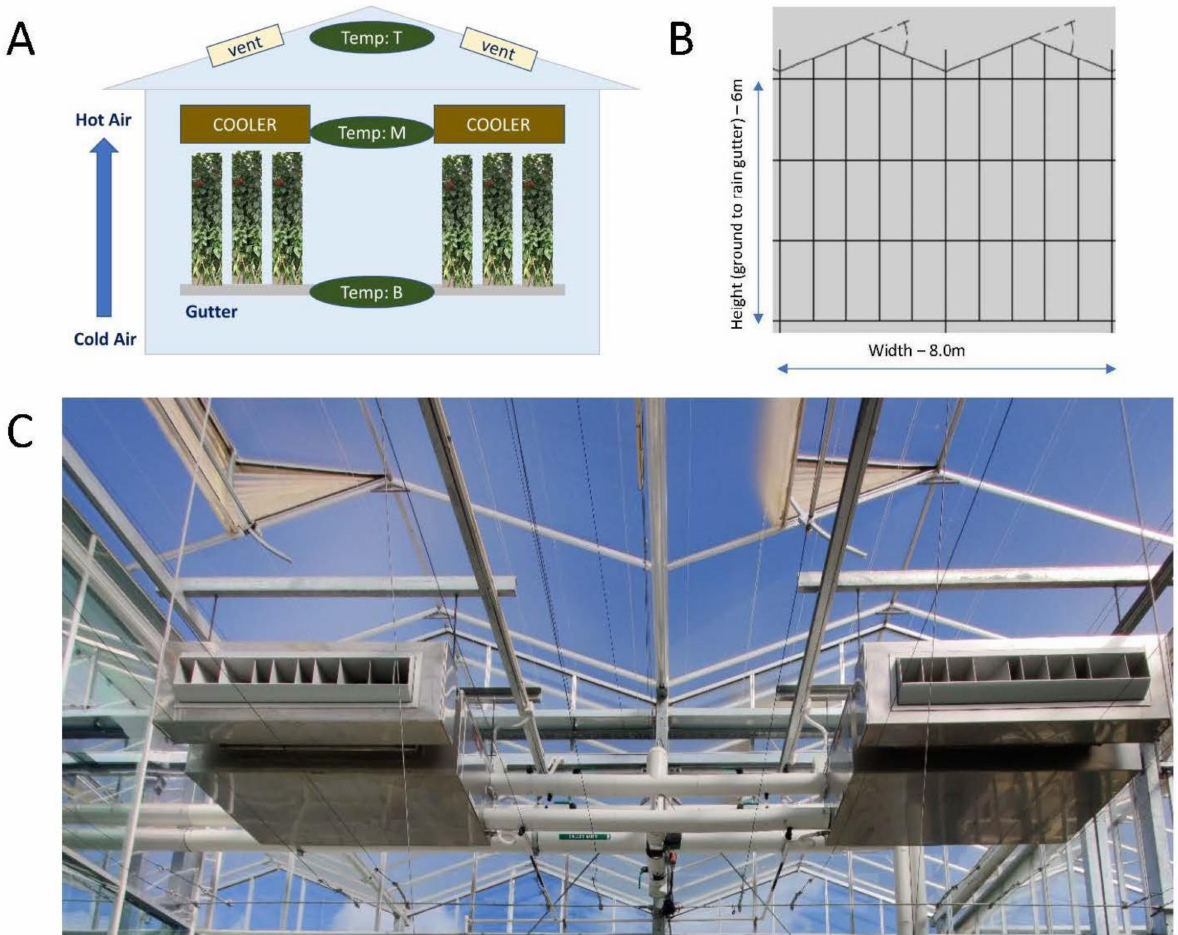
Figure 1. Research design and experimental configuration. ( A ) Schematic diagram of positions of the temperature sensors inside one of the experimental compartments. ( B ) The northwestern side of the greenhouse (13.6 m L × 8.0 m W × 6 m H (ground to rain gutter), depicting that both roof vents open toward the southwest. ( C ) Two mechanical coolers used for temperature control in the